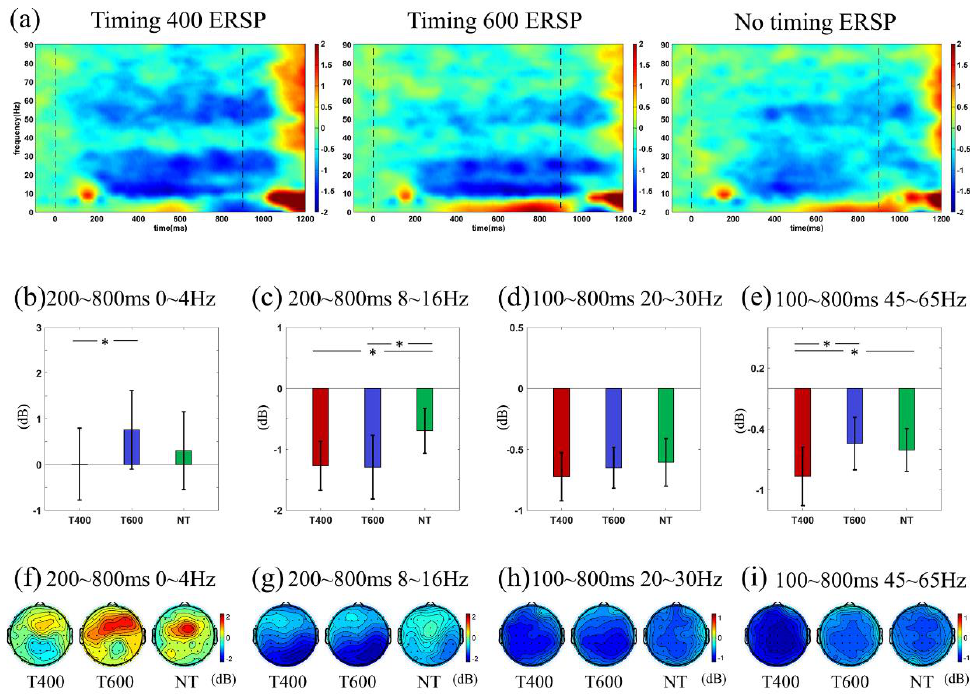
Figure 5. ( a ) ERSP time-frequency distribution. ( b – e ) ERSP values; ( f – i ) ERSP topographies in specific time-frequency window, which were illustrated by title. The numbers in color bars are all measured in decibel (dB). Statistical significance: * 0.01 < p < 0.05.